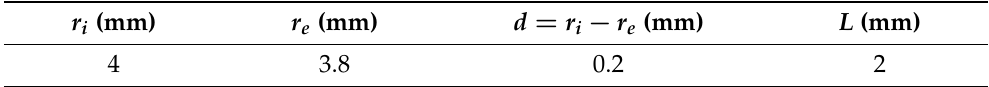
Figure 3. Scheme of an axisymmetric section of a hat-shaped specimen subjected to a compressive load with r i and r e representing the internal and external diameters of the specimen, respectively, r e and L representing the thickness and width of the sheared zone, respectively. and d = r i − The sheared zone is then a crown of length L and thickness d . Table 2. Hat-shaped specimen